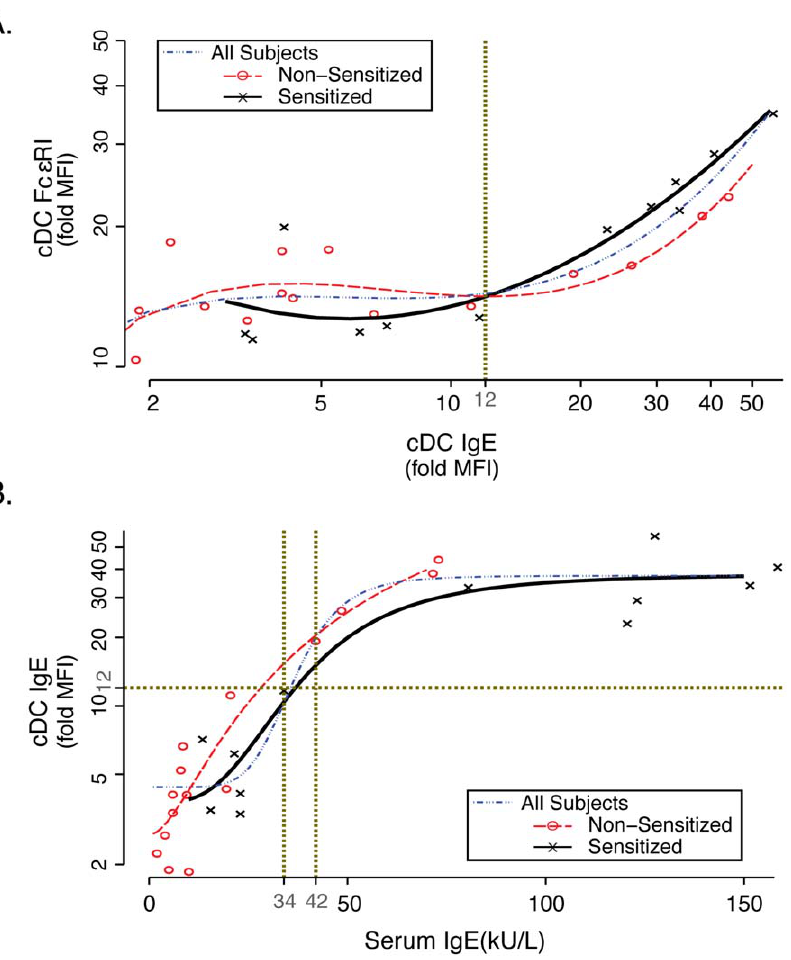
Figure 2. Correlation of cDC expression of Fc e RI with IgE. Expression of Fc e RI and IgE on the surface of cDC was determined by flow cytometry. (A) Data are presented as fold MFI Fc e RI versus fold MFI IgE expression, with non-sensitized subjects (n=15) in red circles and sensitized subjects (n=12) in black x’s. Note the difference in the slope of the fitted lines (non-sensitized subjects in red dotted line; sensitized subjects in black solid line) above and below a fold MFI IgE of 12, suggesting that there is differential regulation of Fc e RI on cDC around this level of cell bound IgE. For all subjects the data was fit with the following cubic equation (blue line): Ln(cDC Fc e RI)=2.26 + 0.72*ln(cDC IgE)-0.43*ln(cDC IgE) 2 + 0.082*ln(cDC IgE) 3 ); r=0.86; p=0.045. For equations based on sensitization status, see Table 3. (B) Expression of cell bound IgE on cDC compared with serum (free) IgE levels. Data are presented as in (A) with fold MFI IgE expression versus serum IgE (kU/L). Note that a cell bound IgE fold MFI of 12 correlates with a serum IgE of around 38 (based on statistical fitting of the curve, this value could range between 34 and 42 kU/L). doi:10.1371/journal.pone.0032556.g002 Table 3. Sensitization status regression models with significant Pearson correlations.